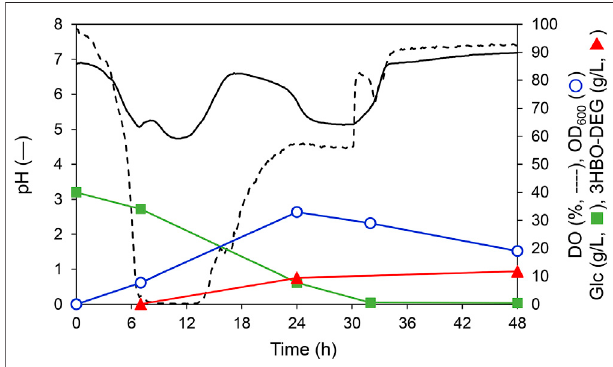
FIGURE 4 | Batch culture of recombinant E. coli BW25113 Δ adhE harboring pGEM- phaRC YB4 AB with a 250-ml mini jar fermenter. The cells were cultured in 100 ml LB medium supplemented with 40 g/L glucose and 50 g/L DEG at 30 ° C, 1 vvm, 600 rpm, pH uncontrolled for 48 h. Triangles denote extracellular 3HBO-DEG concentrations, squares denote the glucose concentration, circles denote cell growth (OD 600 ), the solid line denotes pH, and the dashed line denotes dissolved oxygen